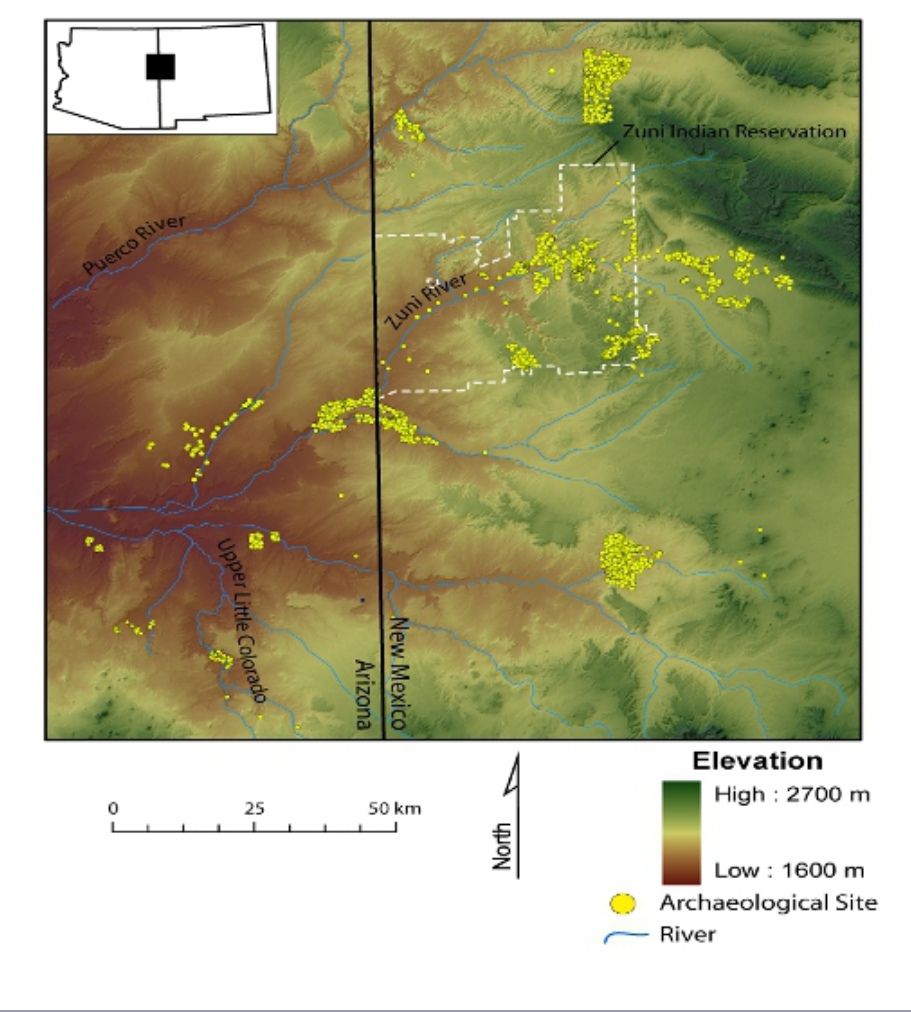
Fig. 5. Map of the Zuni area, with landforms and